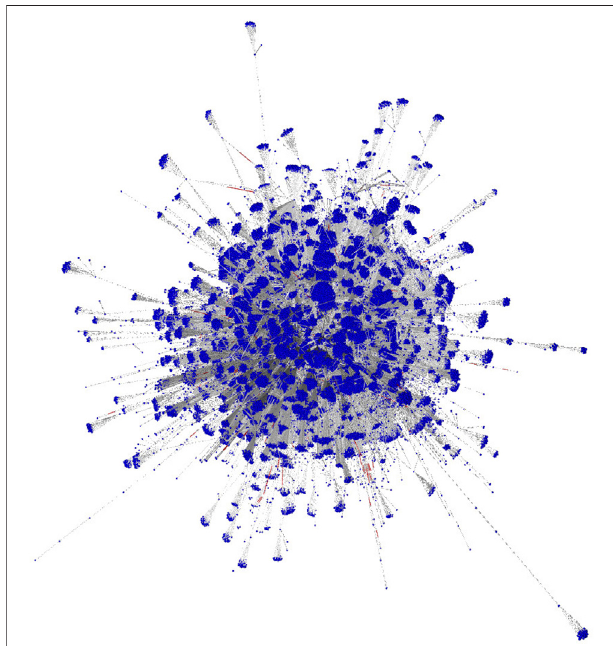
FIGURE 13 | Visualization of the largest strongly connected component in the BNB network, to help visualize the structure of the studied networks.